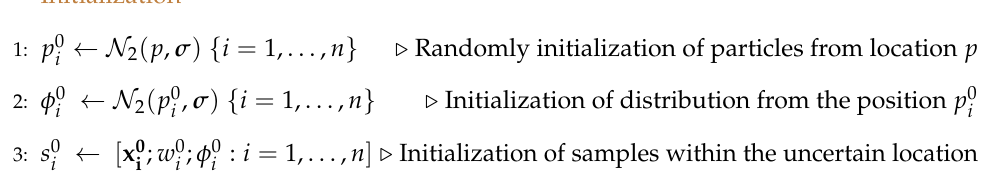
Algorithm 2 Particle filtering for